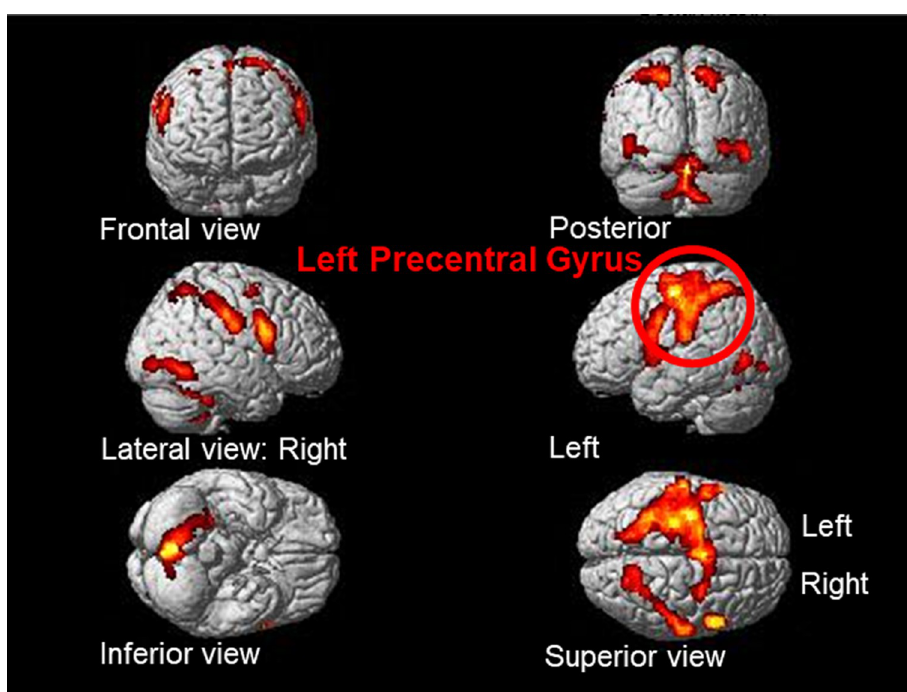
Fig 8. Brain activation for refinement (B2) versus preliminary ideas (B1).